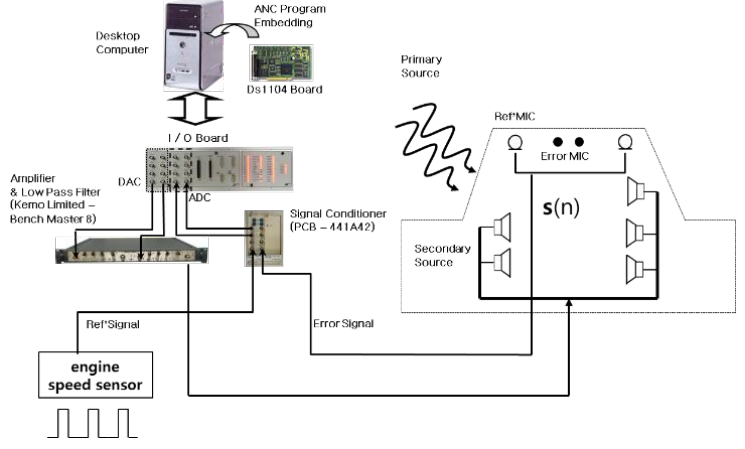
Figure 13. Equipment in the ANC system for active control of interior noise in a test vehicle.